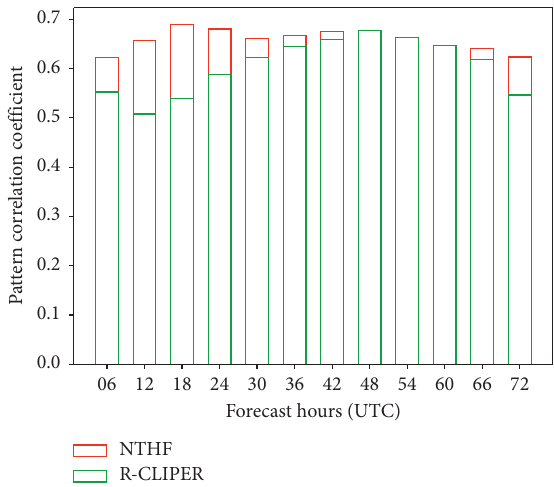
Figure 5: Pattern correlation coefficients. Time evolution of cor- relation coefficient between observations of TRMM and forecasts performed by NTHF (red bars) and R-CLIPER (green bars) is shown. Both forecasts improved with time and exhibited a final decrement. In general, NTHF performed better than R-CLIPER.